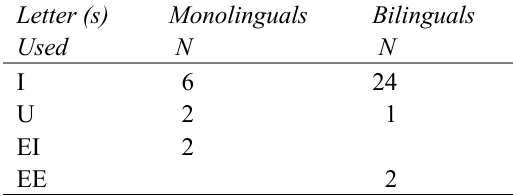
Table 13. Children’s misspellings for the phoneme /ɪ/ in rejune